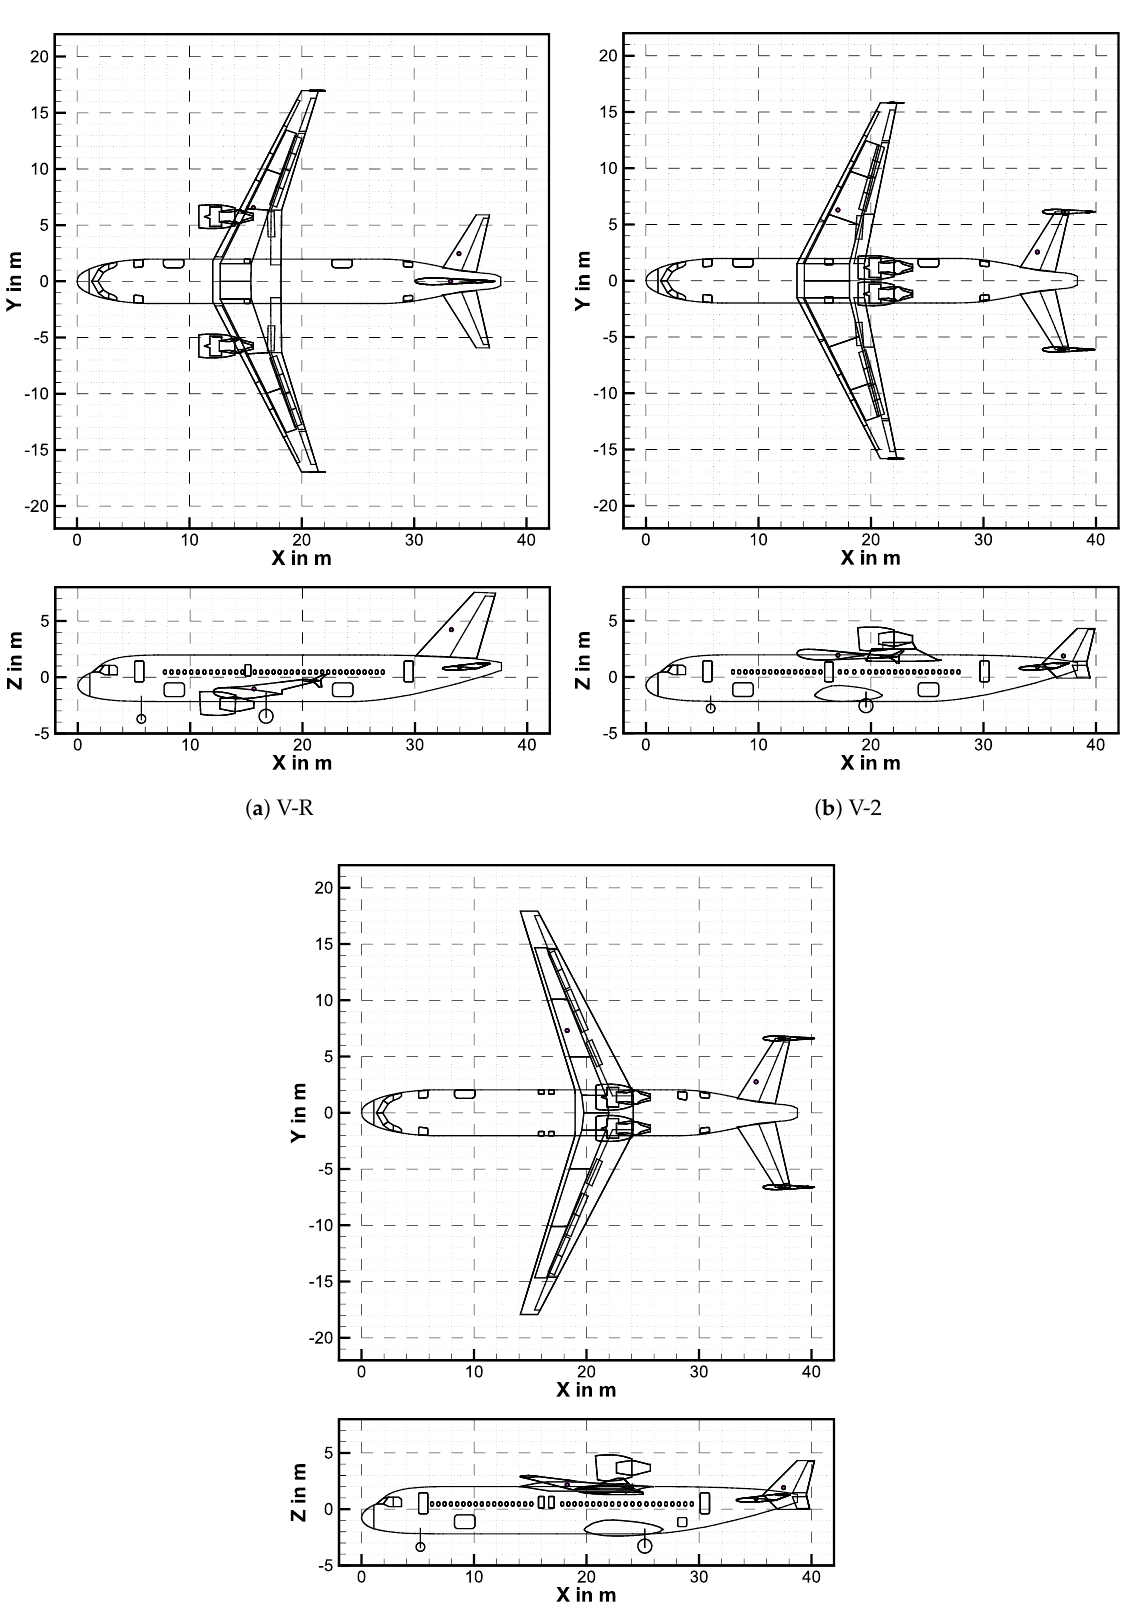
Figure 5. Aircraft designs from